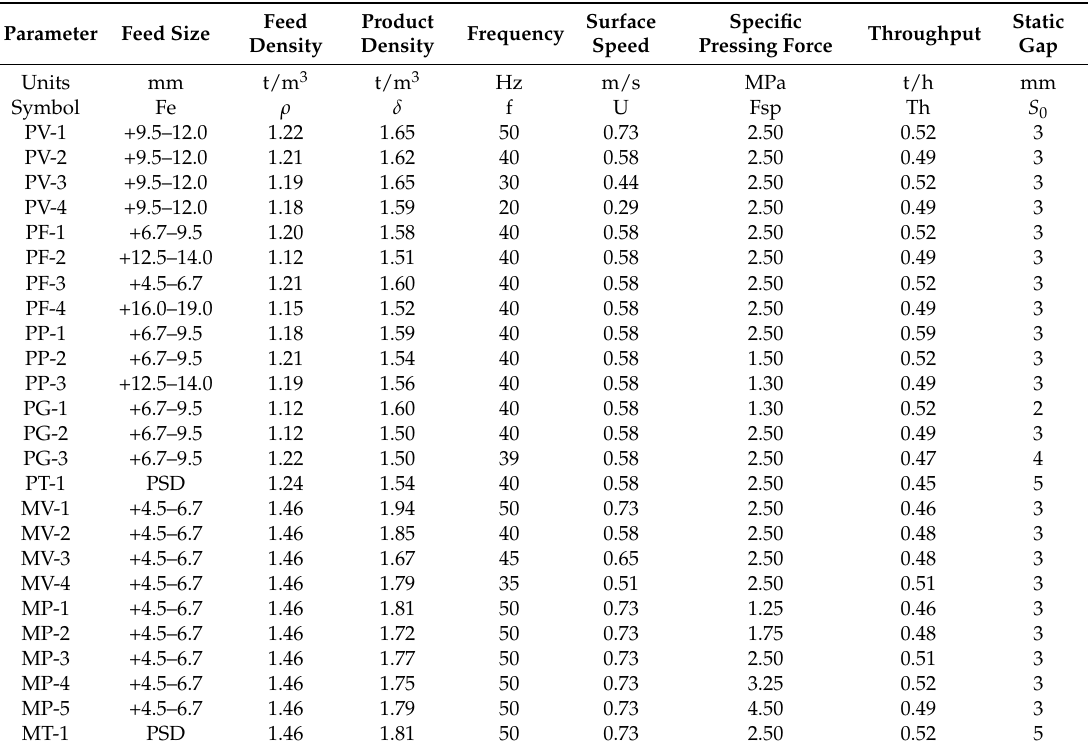
Table 2. Operative conditions for all experiments.